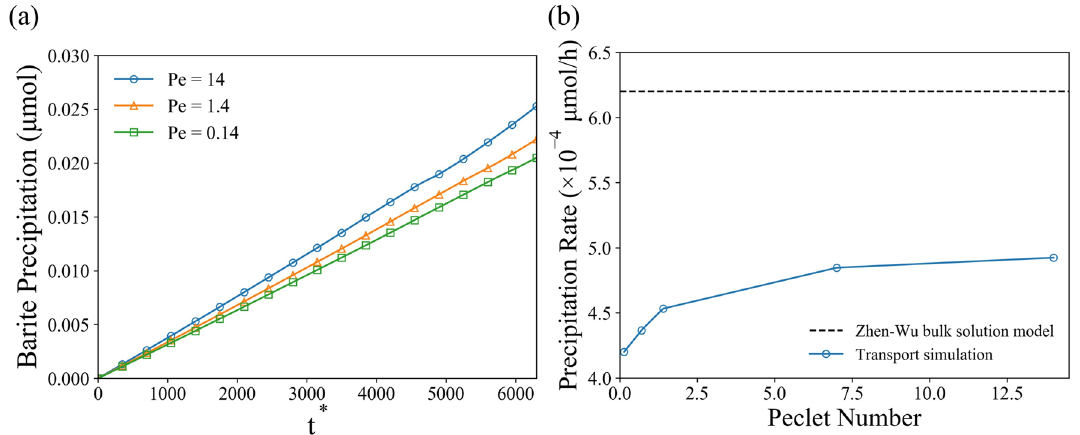
Figure 11. ( a ) Precipitated solid phase mass as a function of nondimensional time for different Péclet number. ( b ) Precipitation rate on particle as a function of Péclet